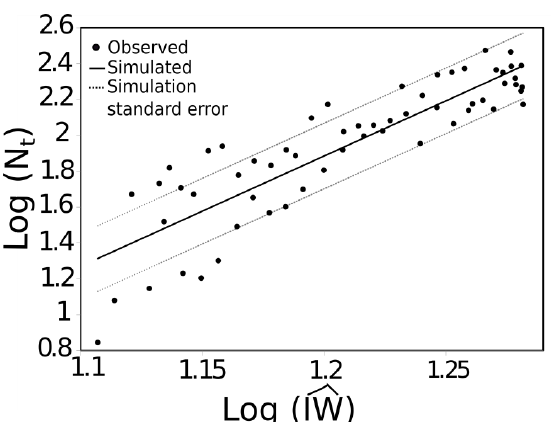
Figure 8. Regional induced-earthquake count N t (M L ≥ M C ) and ˆIW estimator calibrated between years 2006 and 2017 in the state of Oklahoma. The power law explains 77% of the bivariate behavior of monthly injection and earthquakes number. Upper and lower dashed lines representing standard errors of estimates have been added to the mean predicted values.